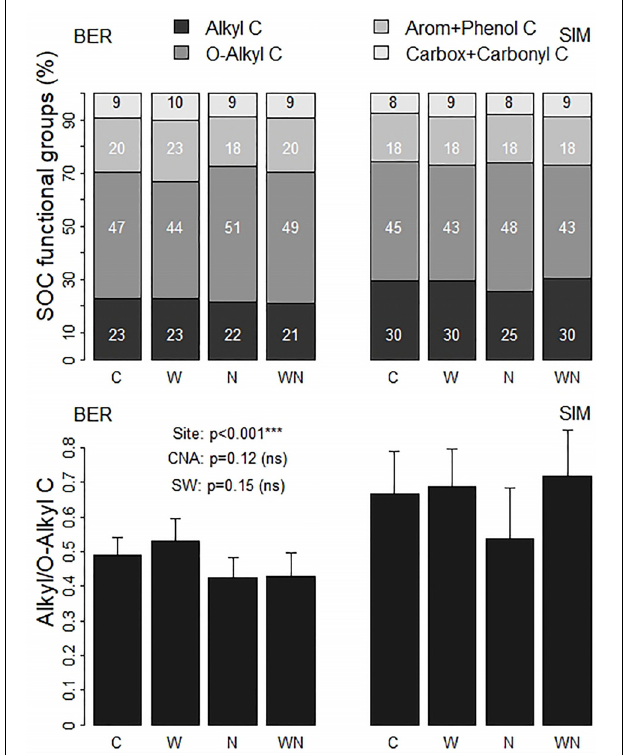
FIGURE 1 | Mean percentages of the four assessed organic C functional groups, and alkyl: O-alkyl C in the C (control), N (fertilized), W (warmed), and WN (warmed and fertilized) plots of both sites at the end of the 9-year experiment. CNA, Canopy N addition; SW, Soil Warming.